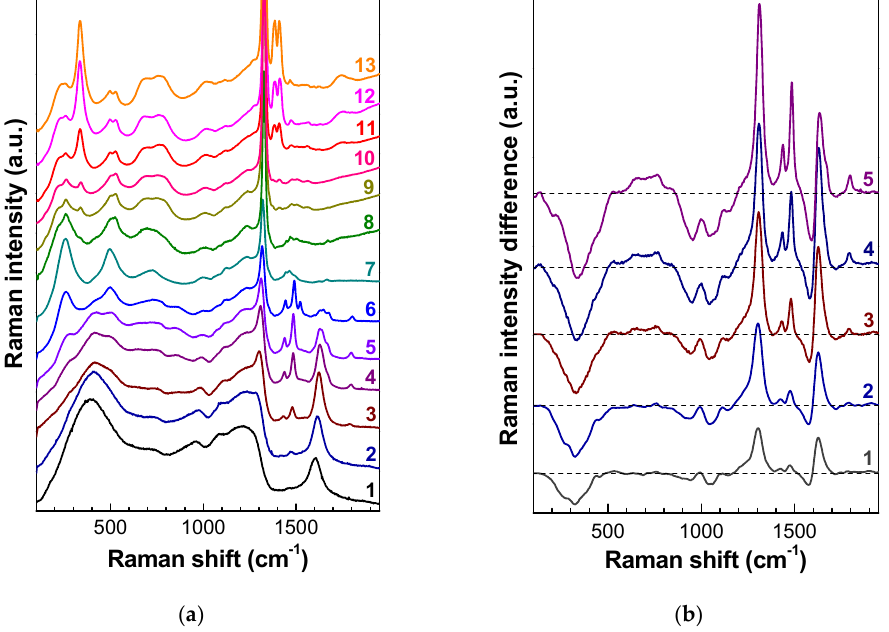
Figure 2. ( a ) Transformation of the Raman spectra of neutron-irradiated diamond with a fluence of 2 × 10 19 cm −2 , depending on the annealing temperature. The annealing temperatures for the spectra were (1) 100 °C, (2) 450 °C, (3) 550 °C, (4) 700 °C, (5) 800 °C, (6) 900 °C, (7) 1005 °C, (8) 1285 °C, (9) 1375 °C, (10) 1465 °C, (11) 1520 °C, (12) 1555 °C, and ( 13 ) 1580 °C. The spectra were recorded on the growth side of CVD diamond with excitation at 488 nm and vertically shifted for clarity. ( b ) Difference spectra between spectrum (1) in (a) and the spectra of the same sample after annealing at (1) 400 °C, (2) 450 °C, (3) 550 °C, (4) 625 °C, and (5) 700 °C.